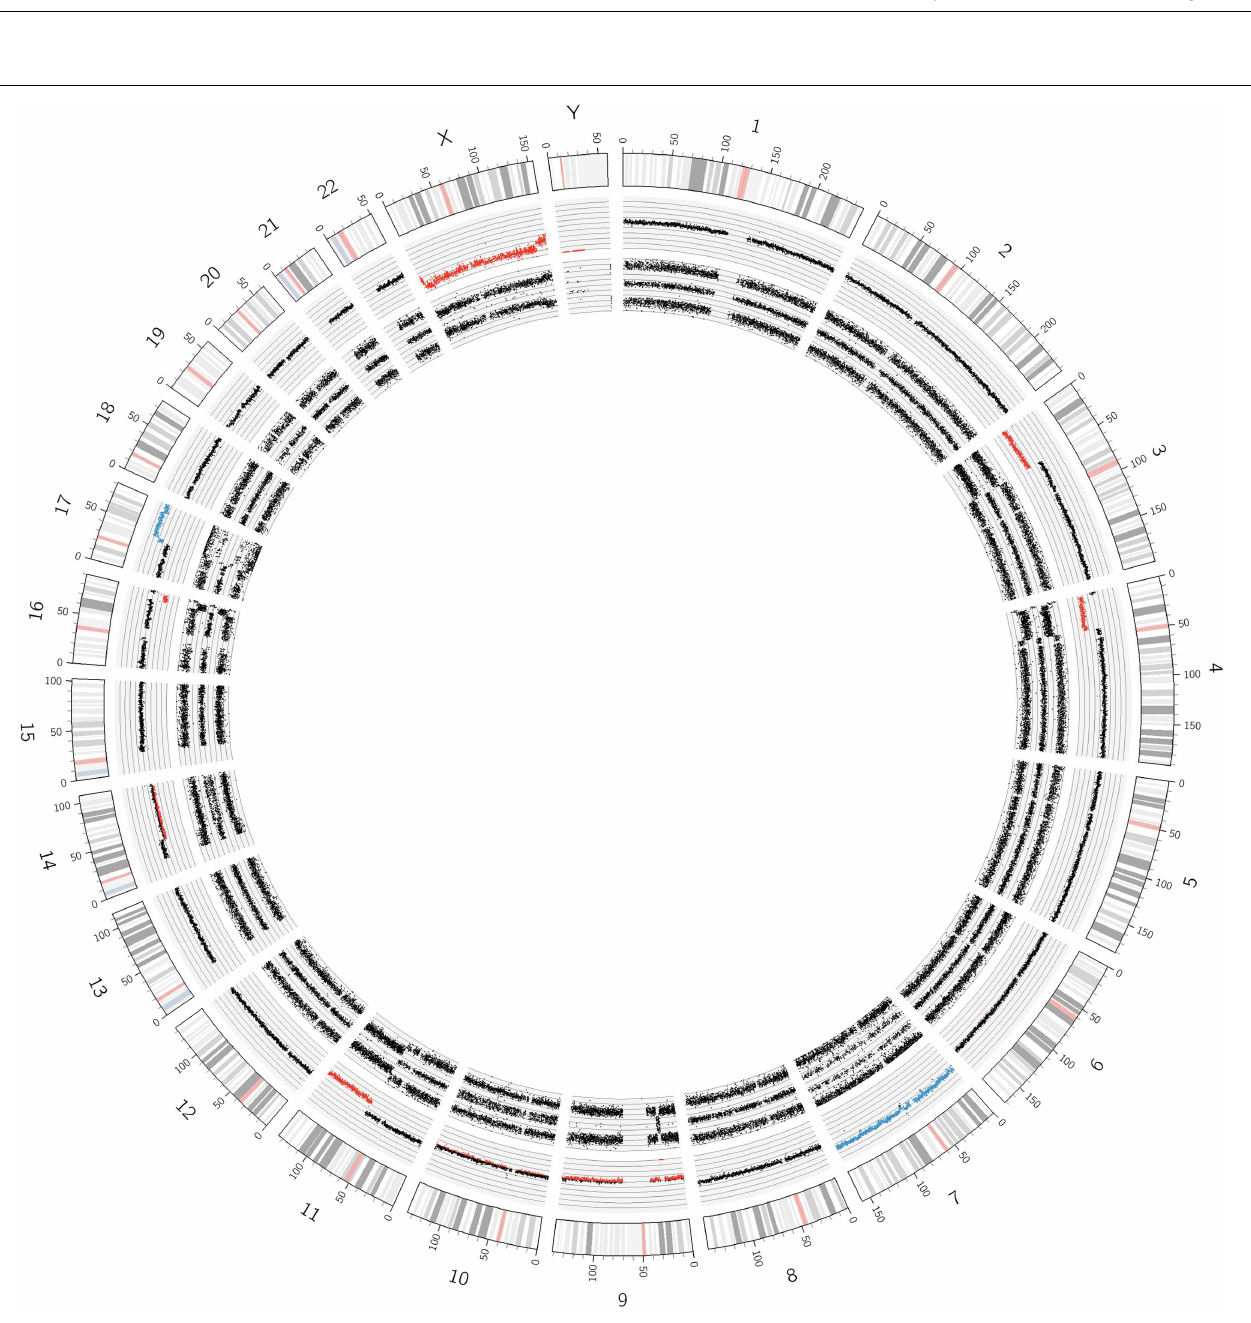
FIGURE 6 |A Circos plot of chromosome 11q deleted neuroblastoma .The red track in the log 2 copy number lane already indicates the loss of genomic material.The two allele peak tracks indicate LOH. In addition, the short arms of chromosomes 3 and 4 and the long arm of chromosome 16 show deletions